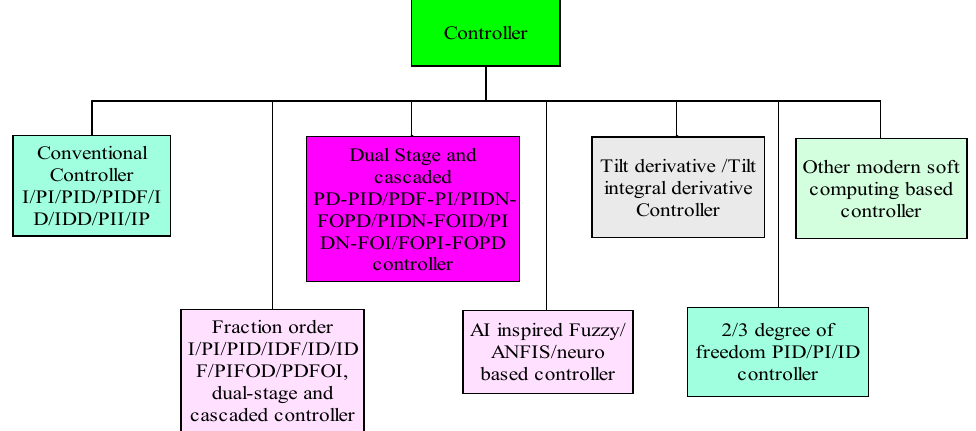
Figure 4. Classification of controller used for LFC in the different power system models .